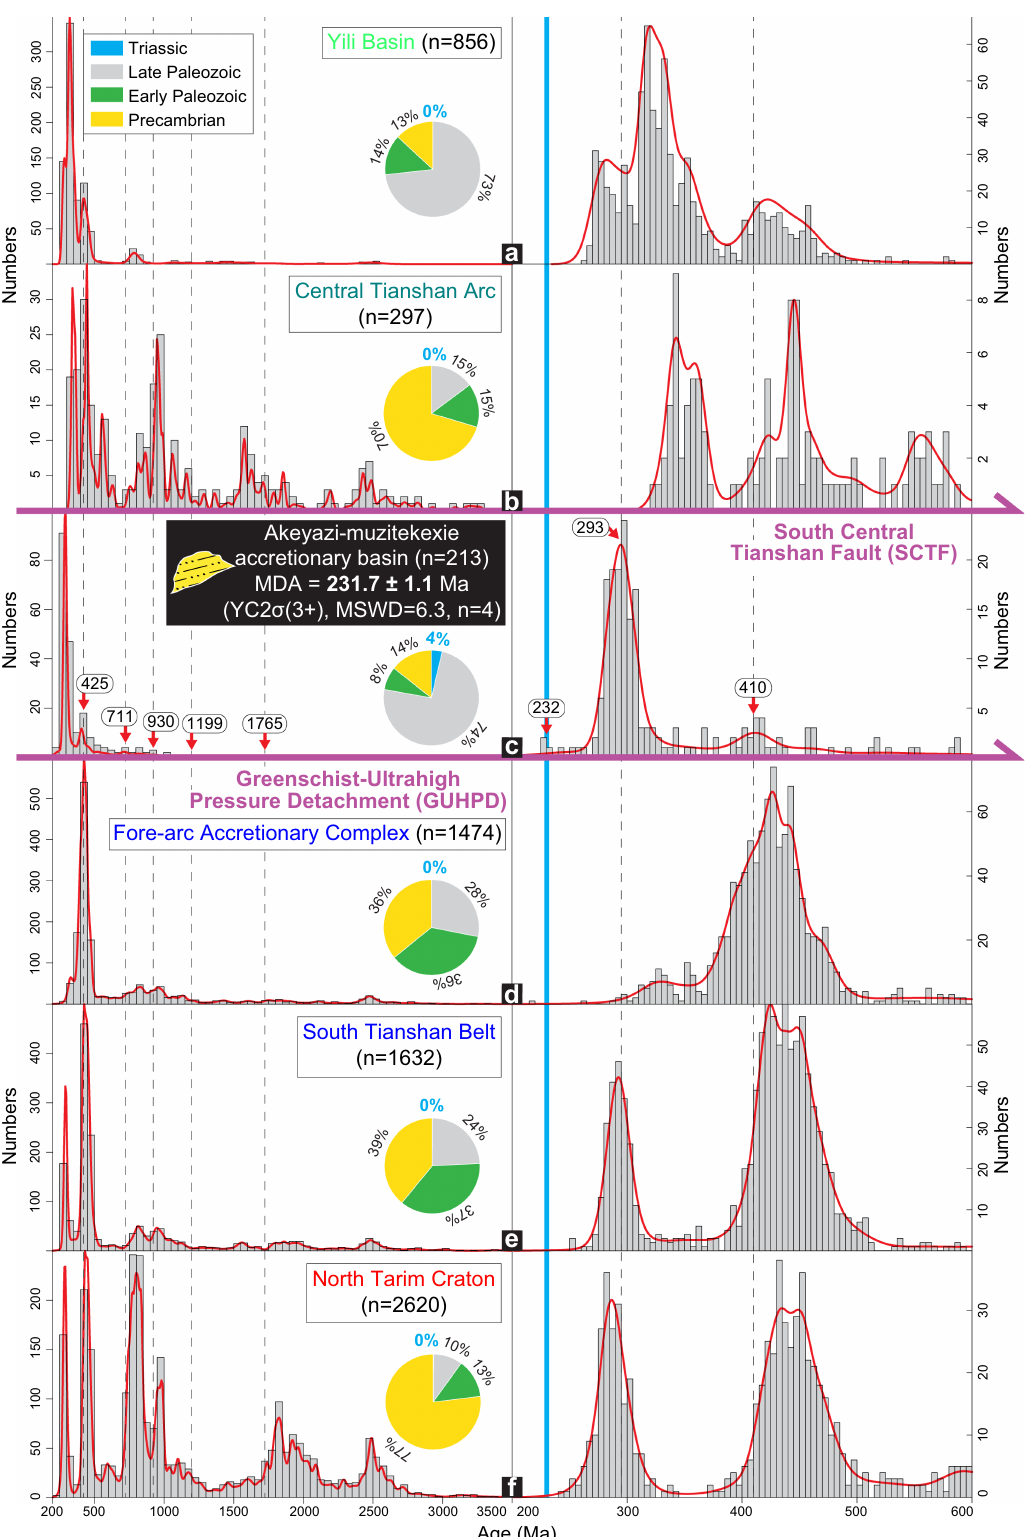
Fig. 6 KDE plots of detrital zircon U-Pb ages of sediments in adjacent key tectonic units. a Yili Basin, b Central Tianshan Arc, c Triassic MAFB (this study), d Fore-arc accretionary Complex, e South Tianshan Belt, and f North Tarim Craton. The proportion of Triassic, late Paleozoic, early Paleozoic, and Precambrian detrital zircons, as well as the maximum depositional ages (MDA, blue solid-line) of Triassic MAFB, are highlighted for comparison. Relevant data are listed in Table S2 and